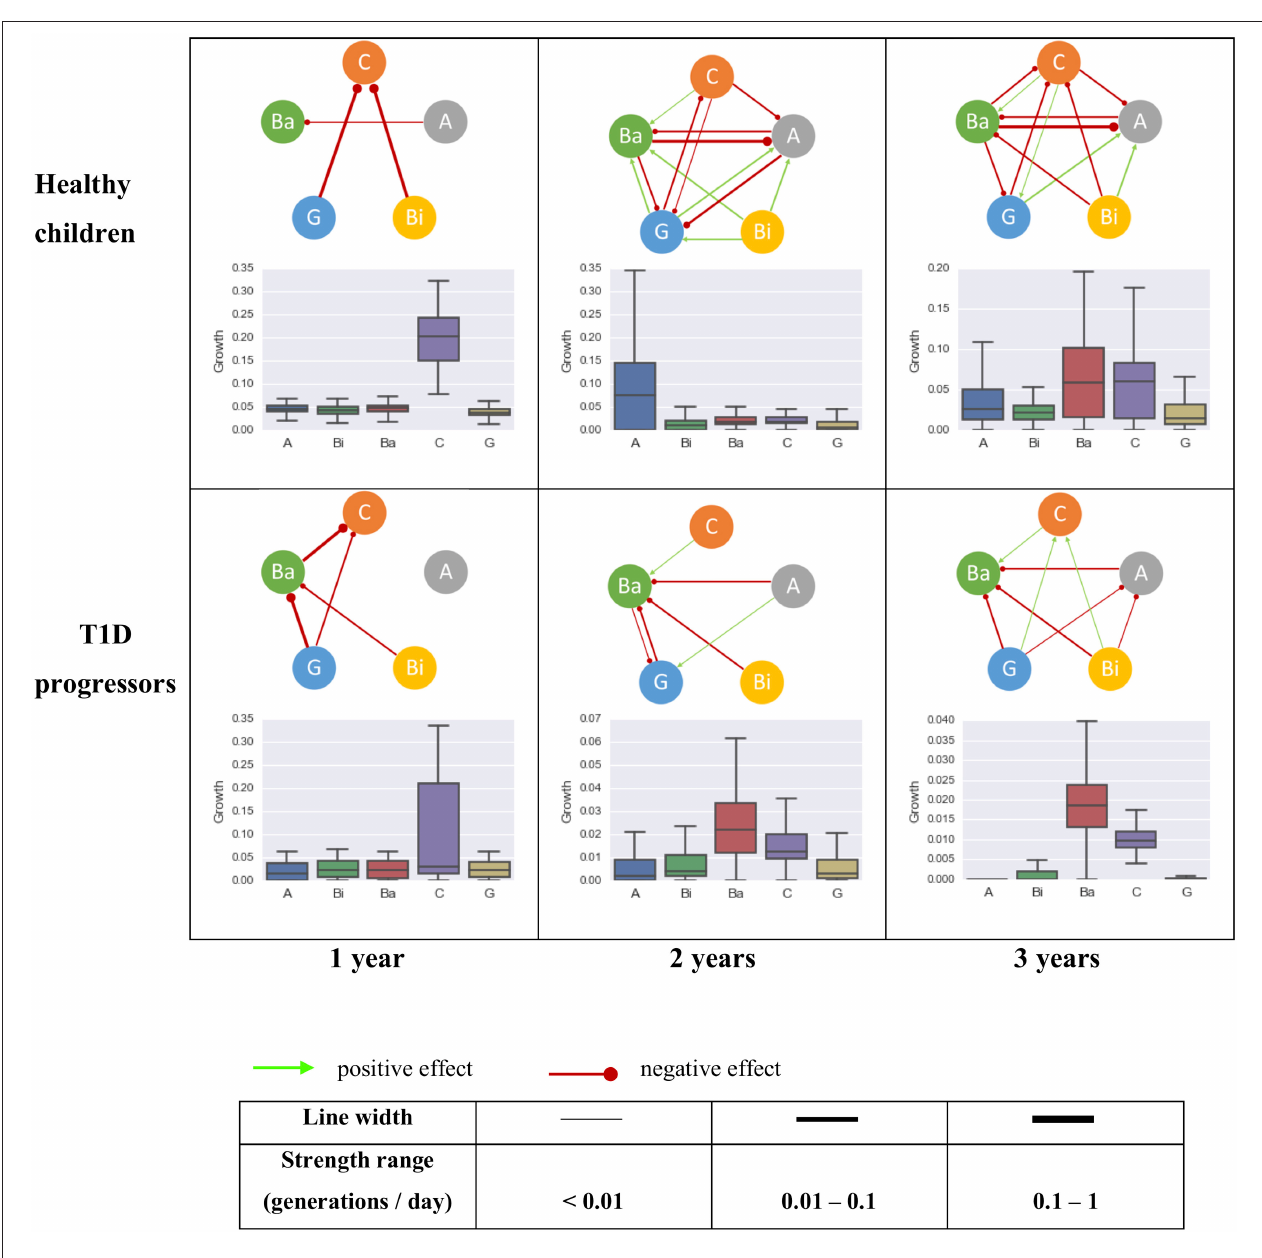
FIGURE 4 | The intrinsic growth rates of five most abundant bacterial classes and their interactions within the gut microbiome community of healthy (top row, control) and T1D progressors (bottom row, case) at 0–1 year (left column), 0–2 years (mid column), and 0–3 years (right column) of age. The line thickness is proportional to the strength of the interaction. A, Actinobacteria ; Bi, Bacilli ; Ba, Bacteroidia ; C, Clostridia ; G, Gammaproteobacteria .